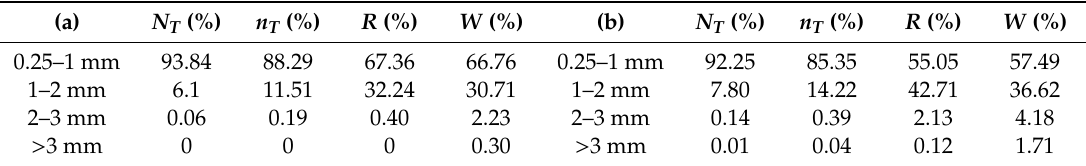
Table 3. Contributions of raindrops with di ff erent sizes to microphysical parameters for precipitation from ( a ) stratiform precipitation and ( b ) convective precipitation. Note: N T (total raindrop concentration), n T (total number of particles), R (rainfall intensity), W (liquid water content).